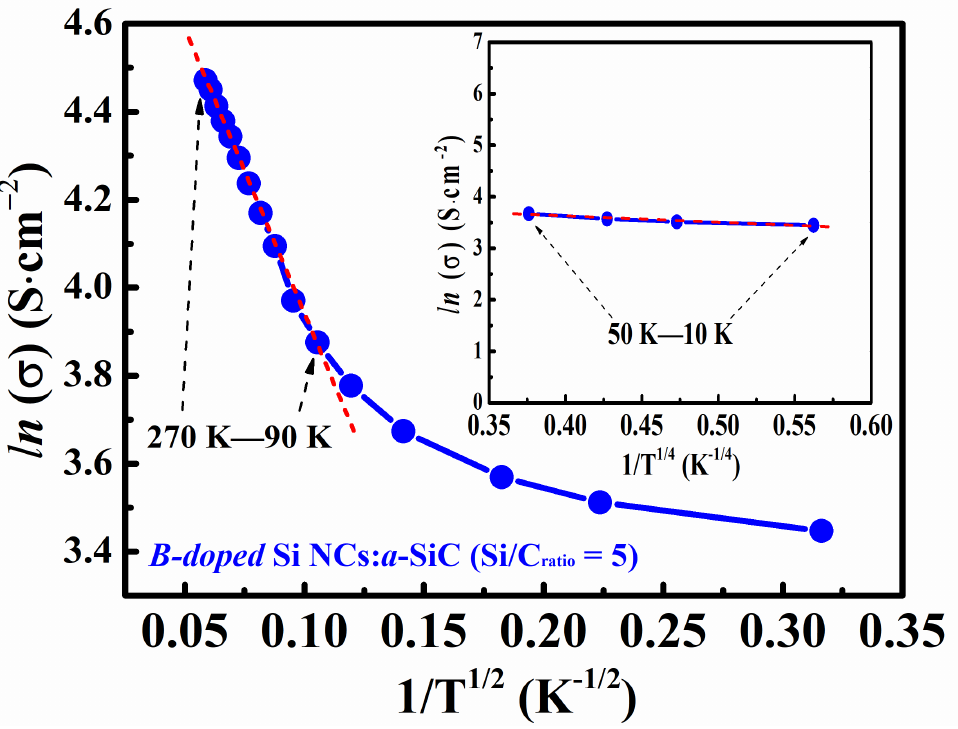
Figure 6. The ln σ plotted as a function of T − 1/2 of the B-doped Si NCs: a -SiC film with R = 5; the insert is the ln σ plotted as a function of T − 1/4 at the temperature from 10 K to 50